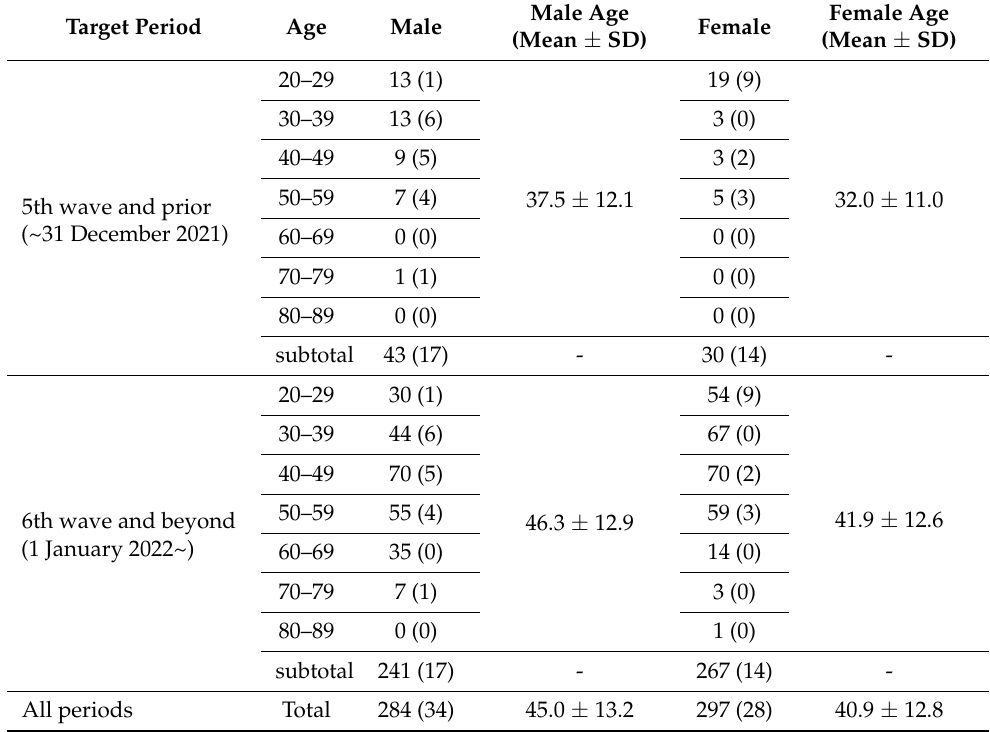
Table 3. Distribution of age of the participants. The number in parentheses represents the counts of the participants in the sex- and age-matched groups, which is extracted to build machine learning models.